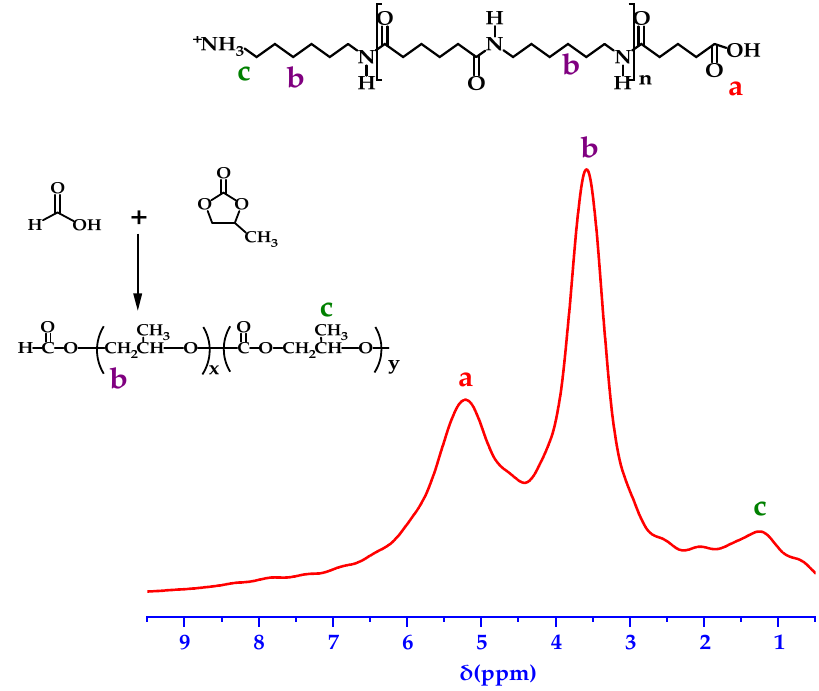
Figure 4. 1 H NMR of the P3 membrane.